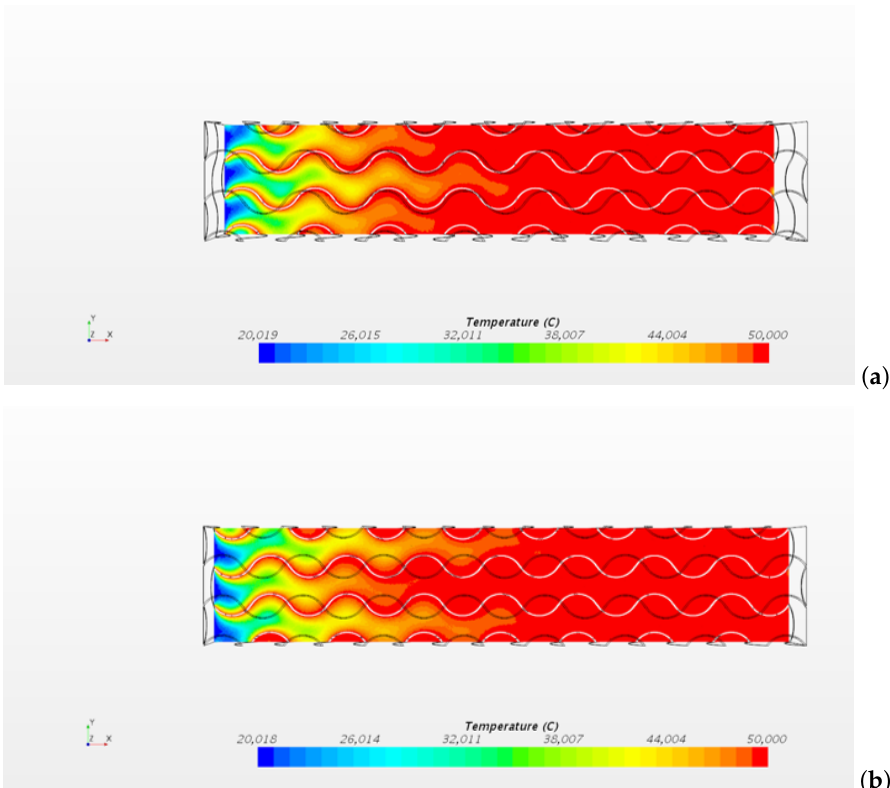
Figure 10. Temperature distribution obtained for the case Re = 3.6, T s = 50 ◦ C on the planes z / W = 1/3 ( a ) and z / W = 2/3 ( b